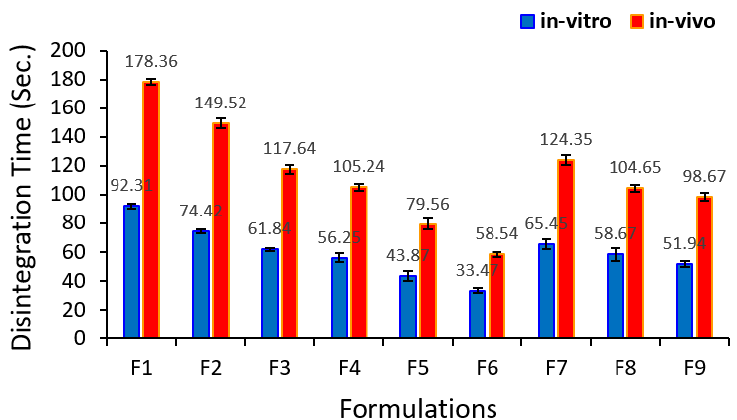
Figure 4. In vitro and in vivo disintegration time (mean ± SD) for all metformin formulations based on the 3 2 full factorial design.